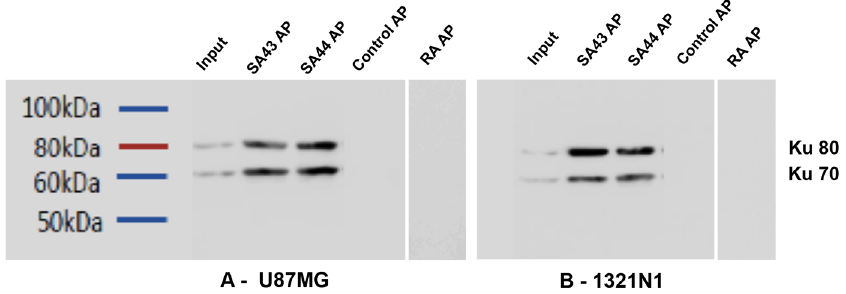
Fig 8. Aptamers, SA43 and SA44, bind to the DNA repair proteins, Ku 70 and Ku 80. Aptamer precipitation (AP) with either SA43 or SA44 was performed with streptavidin agarose beads with protein extracts prepared from either U87MG or 1321N1. Whole-cell extracts (input) and aptamer precipitated proteins were analysed by immunoblotting (WB) using Ku 70 and Ku 80 antibody sequentially on the same blot. The control AP contained no aptamer and random aptamer